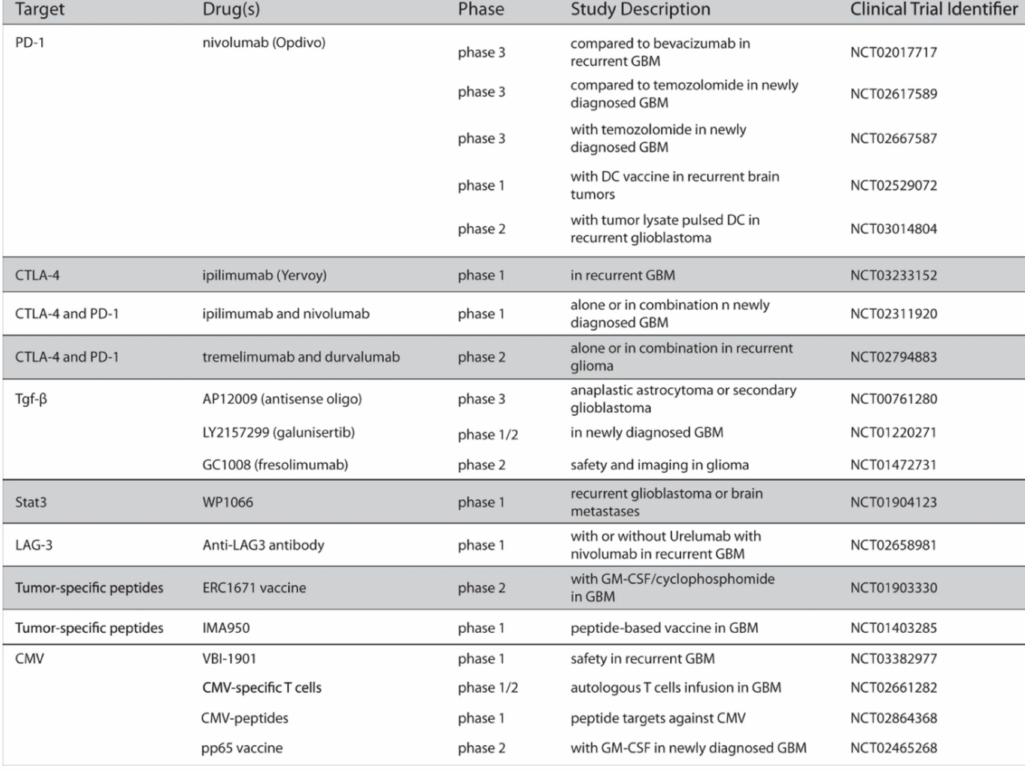
Figure 6. Therapies in clinical trials for high-grade gliomas [77]. Used with